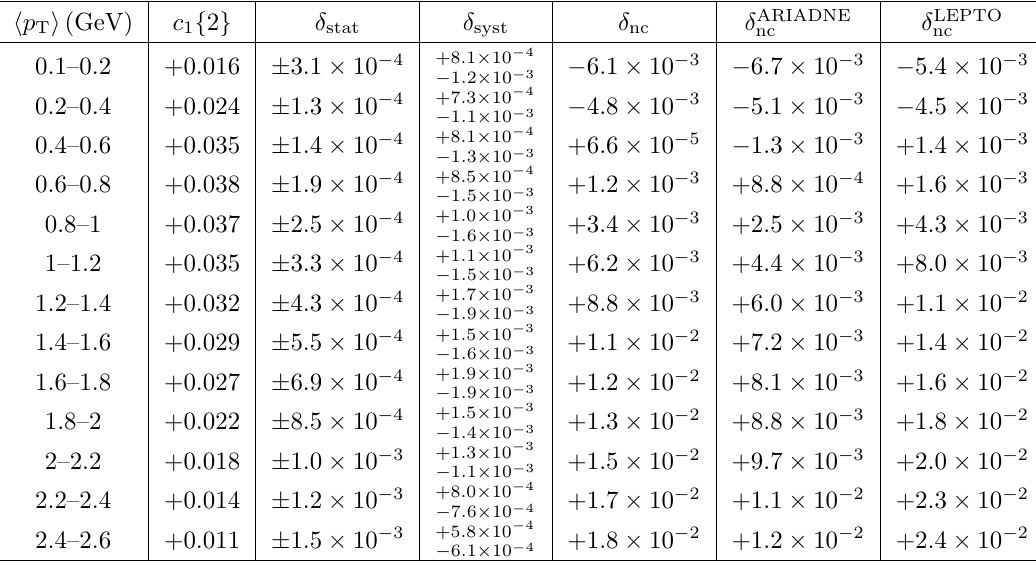
Table 25 . c 1 f 2 g versus h p T i from (cid:12)gure 11 (b), 15 (cid:20) N ch (cid:20) 30, p T > 0 : 1 GeV, no j (cid:1) (cid:17) j